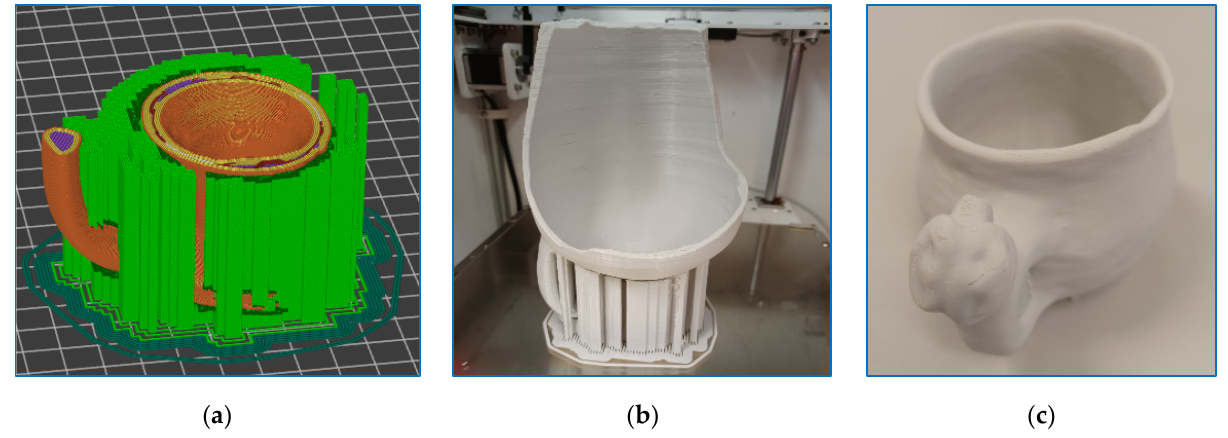
Figure 6. View of the objects: ( a ) layered model of the jug ready for printing (25% of the height); ( b ) a printed replica of the jug with supports; ( c ) a printed mug after cleaning it off supports. Table 2. The printing